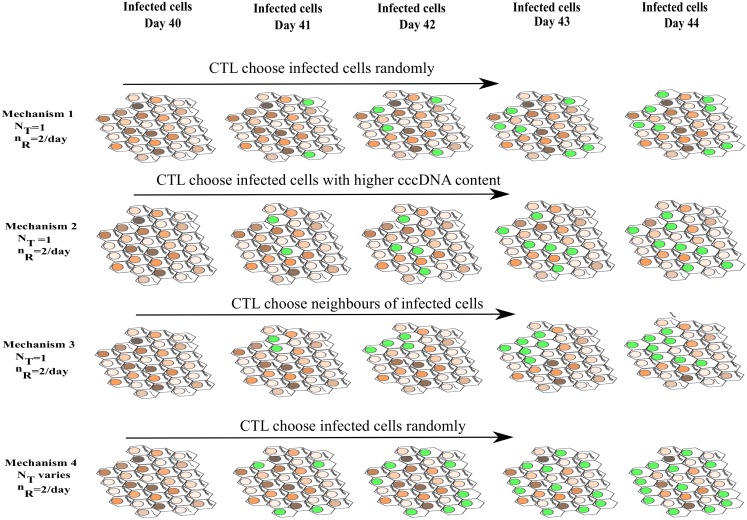
Four possible scenarios describing CTL removal of infected cells.In the figure, the cell (represented by a hexagon) with the highest cccDNA content in the nucleus (represented by an ellipse) is shown with the darkest shade of brown. A nucleus coloured green represents the pattern of infected cells killed by CTL under each mechanism. The first three mechanisms remove a constant number of infected cells (nR×NT) per day regardless of the number of infected cells, whereas the clearance rate of infected cells by mechanism 4 increases with an increase in the number of infected cells. All four mechanisms assume that there are NT HBV-specific CTLs after day 45 when the adaptive immune system is assumed to commence. Mechanism 1 kills infected cells randomly; mechanism 2 prioritises infected cells with the highest cccDNA content while mechanism 3 first kills a cell with the highest cccDNA content followed by one of its infected neighbours, also with the highest cccDNA content and so on. So mechanism 3 results in CTL following a path through an infected cluster. On the other hand, mechanism 4 assumes that the T cell clearance number varies relative to the infection level, killing infected cells randomly.